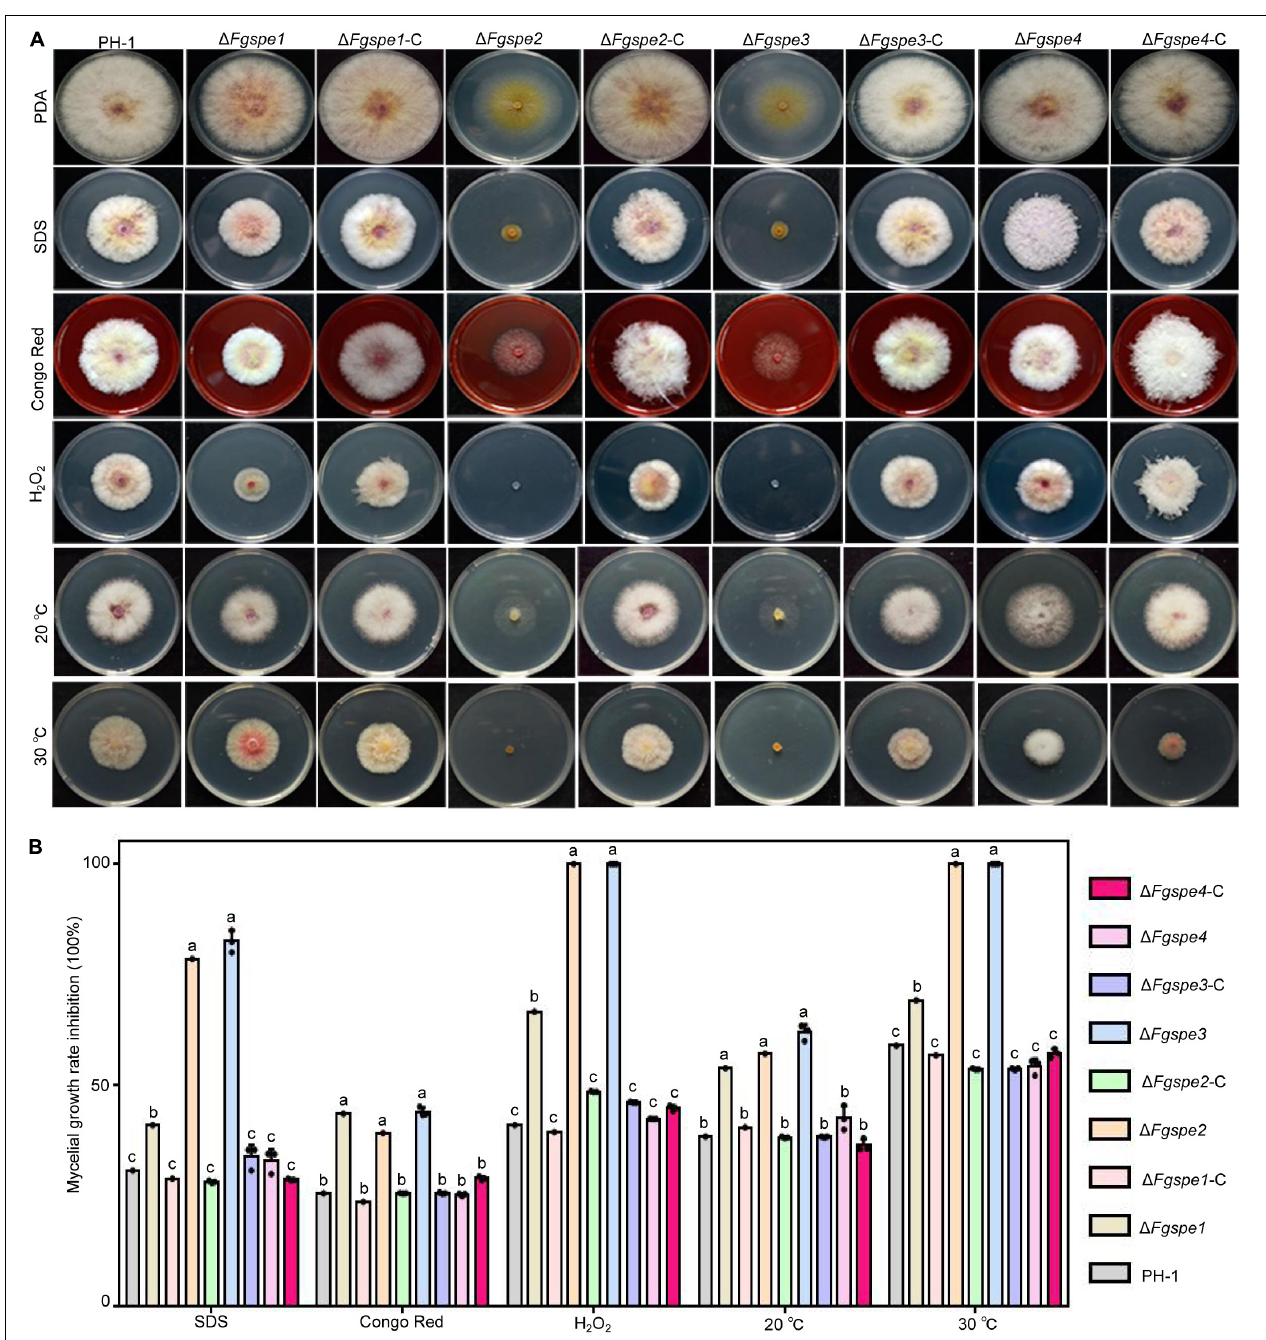
FIGURE 5 | (cid:49) Fgspe2 and (cid:49) Fgspe3 mutants have increased sensitivities to environmental stresses. (A) Sensitivity assay of deletion mutants to 0.02% SDS, 0.2 g/L Congo Red, 0.02% H 2 O 2 , and different temperatures. (B) The mycelial growth inhibition rate of each strain was examined after 3 days on PDA. Columns listed with the same letter are not significantly different at P = 0.05.